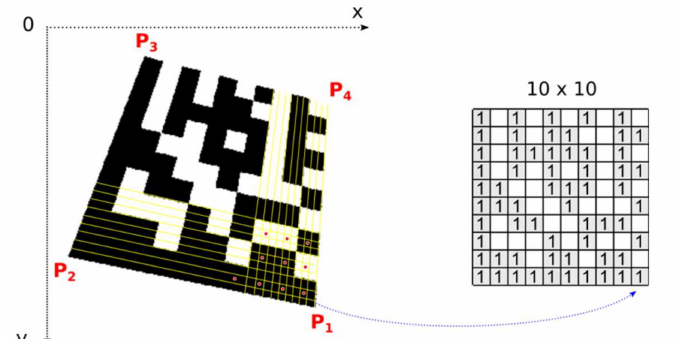
Figure 18. Transformation of the Data Matrix code from the image domain into the binary matrix.